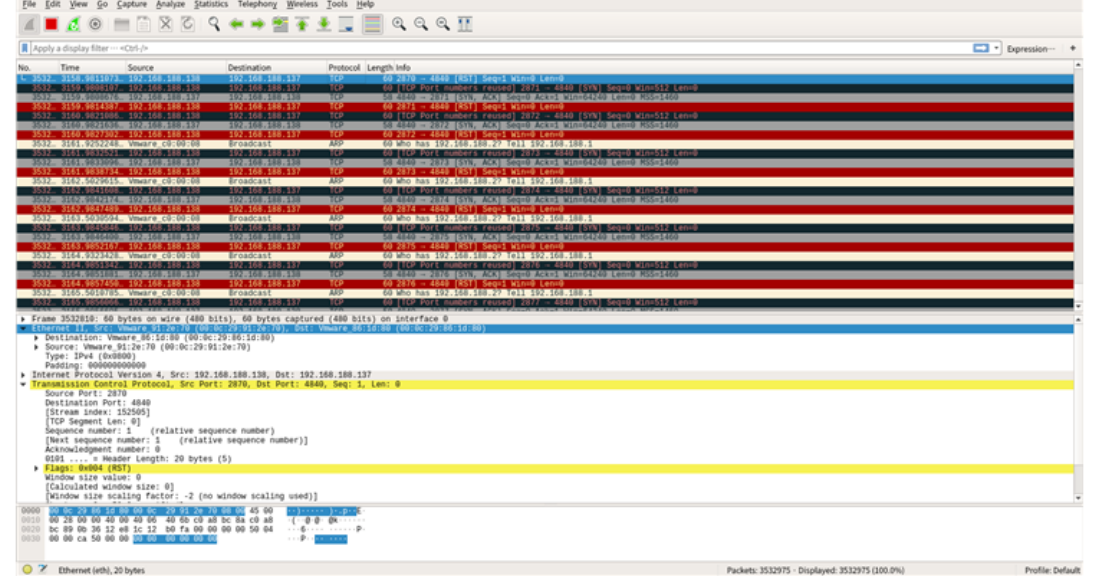
Figure 17. Wireshark screen of the victim under an SYN flooding attack.